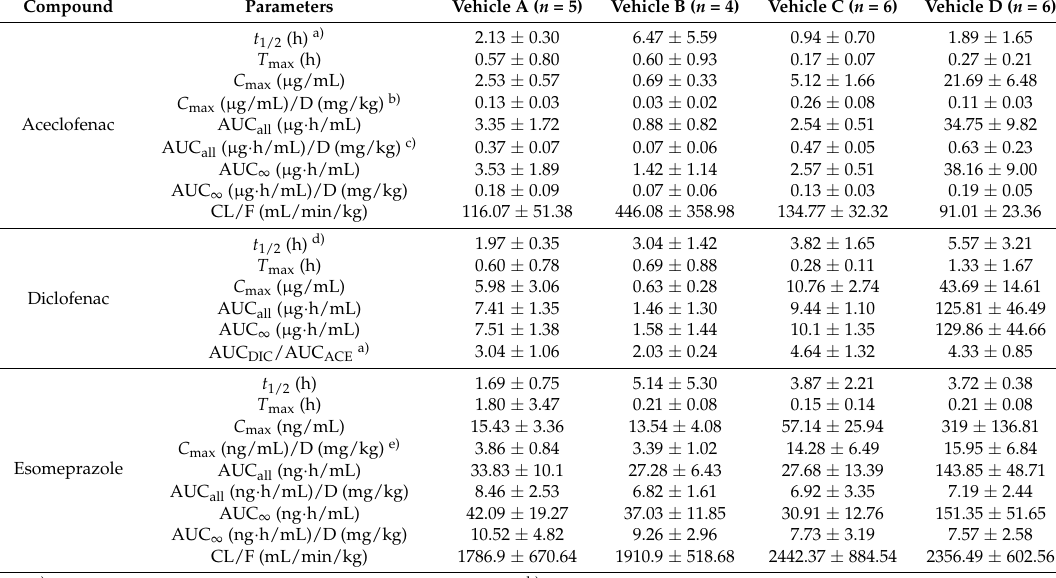
Table 2. Non-compartmental pharmacokinetic parameters of aceclofenac and diclofenac obtained after oral administration of vehicle A, B, C, and D containing aceclofenac (20 mg/kg for A, B, and C and 200 mg/kg for D) and esomeprazole (4 mg/kg for A, B, and C and 20 mg/kg for D) to rats.